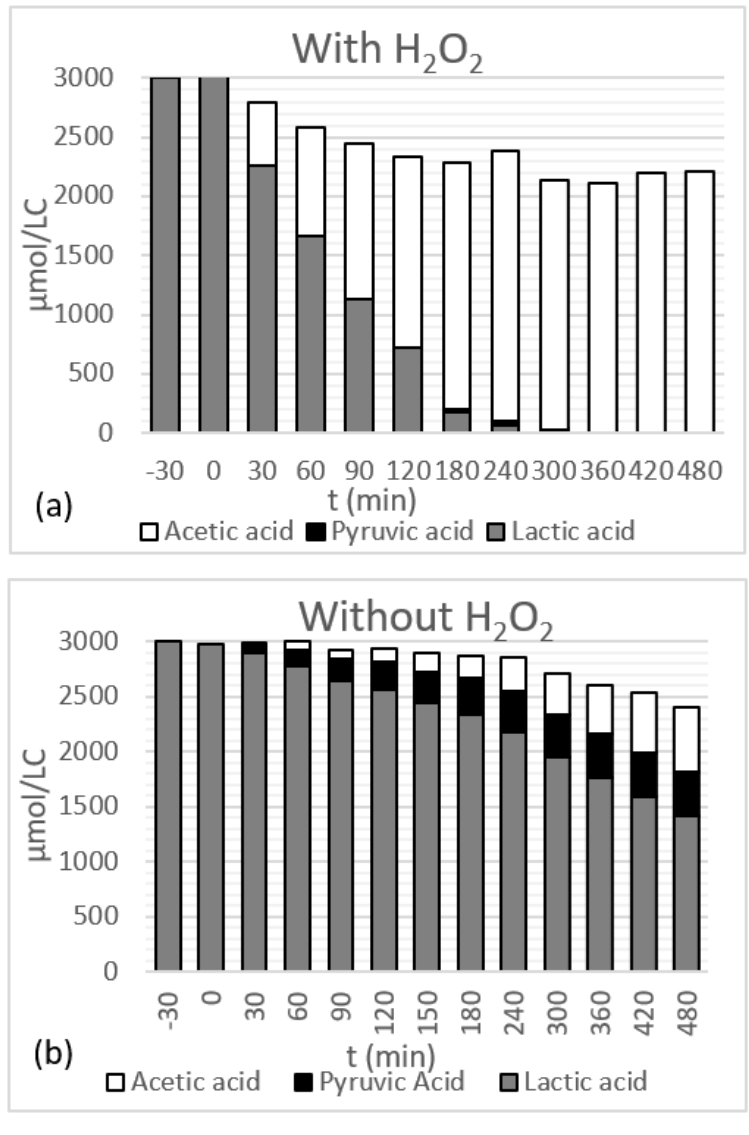
Figure 9. Carbon balance of the degradation of LA in the presence ( a ) and the absence ( b ) of H 2 O 2 , including the formation of acetic acid and pyruvic acid and the degradation of LA.